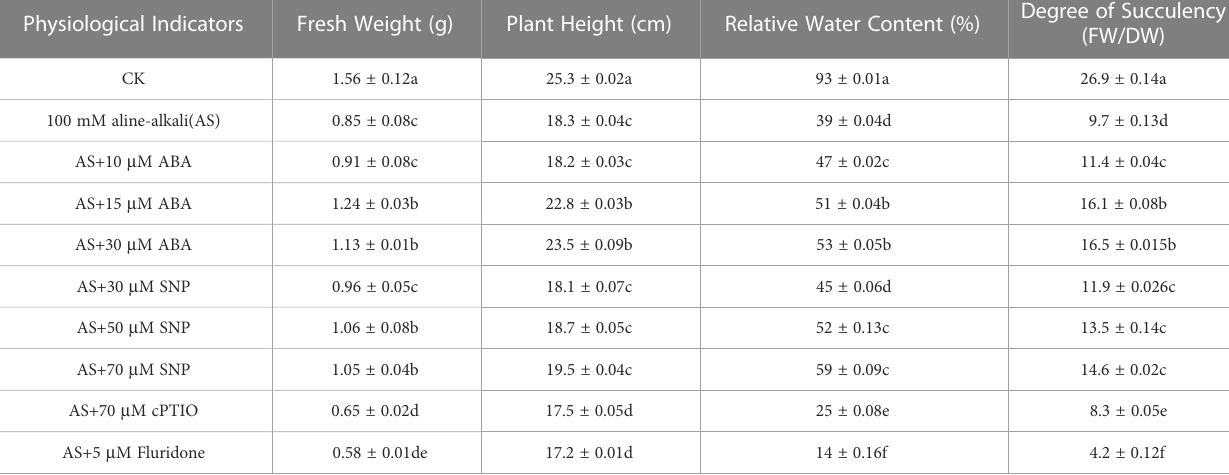
TABLE 1 Physiological indicators of N. tangutorum applied various concentrations of ABA and SNP under 100mM alkali stress.